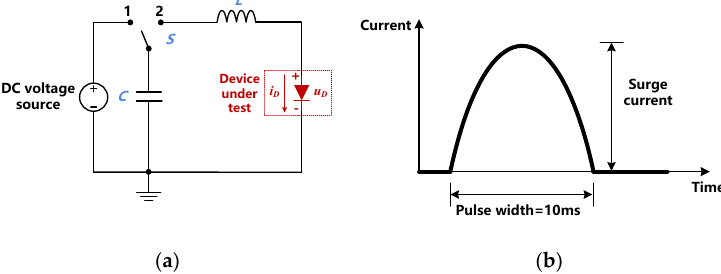
Figure 3. ( a ) The circuit of the test bench and ( b ) the waveform of the current pulse for the surge current capability tests.